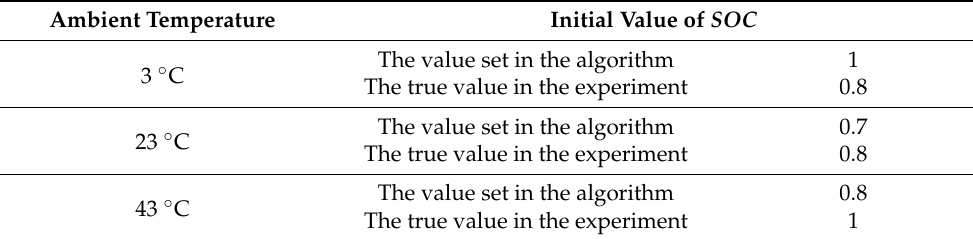
Table 7. Condition setting of SOC estimation algorithm verification.